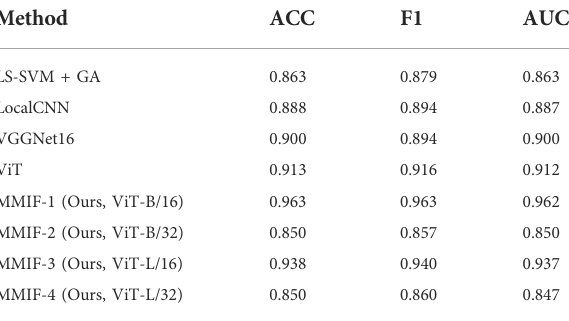
TABLE 3 Test results of our methods and baseline methods for FDD pathological diagnosis